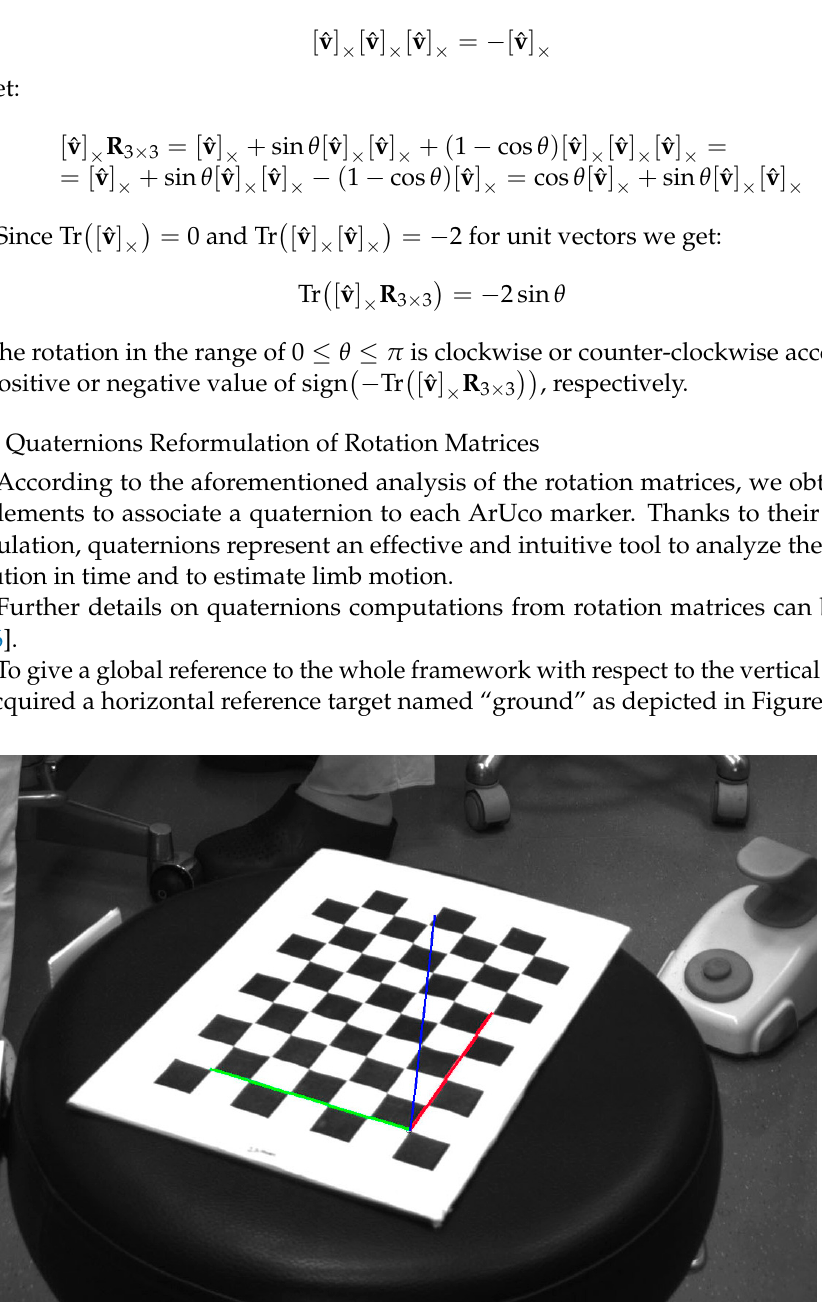
the very beginning of each